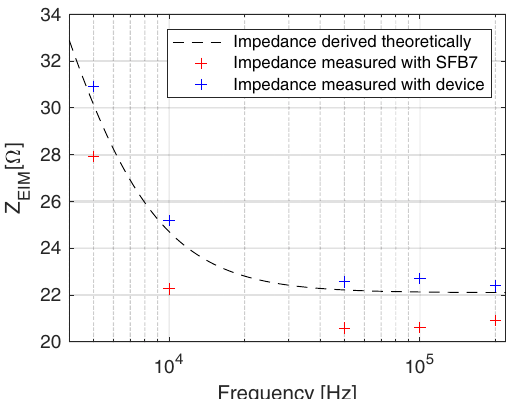
Figure 12. Impedance value of the RRC network over different frequencies. Values measured with our device (blue) are compared with values measured with SFB7 (red) and theoretical values